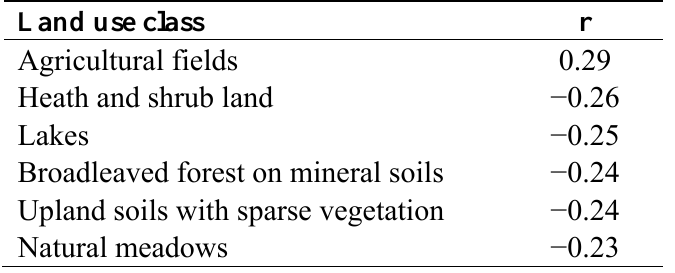
Table 1. Correlation between SMD error ( = snow depth – SAL) and fraction of land-use class around the measurement